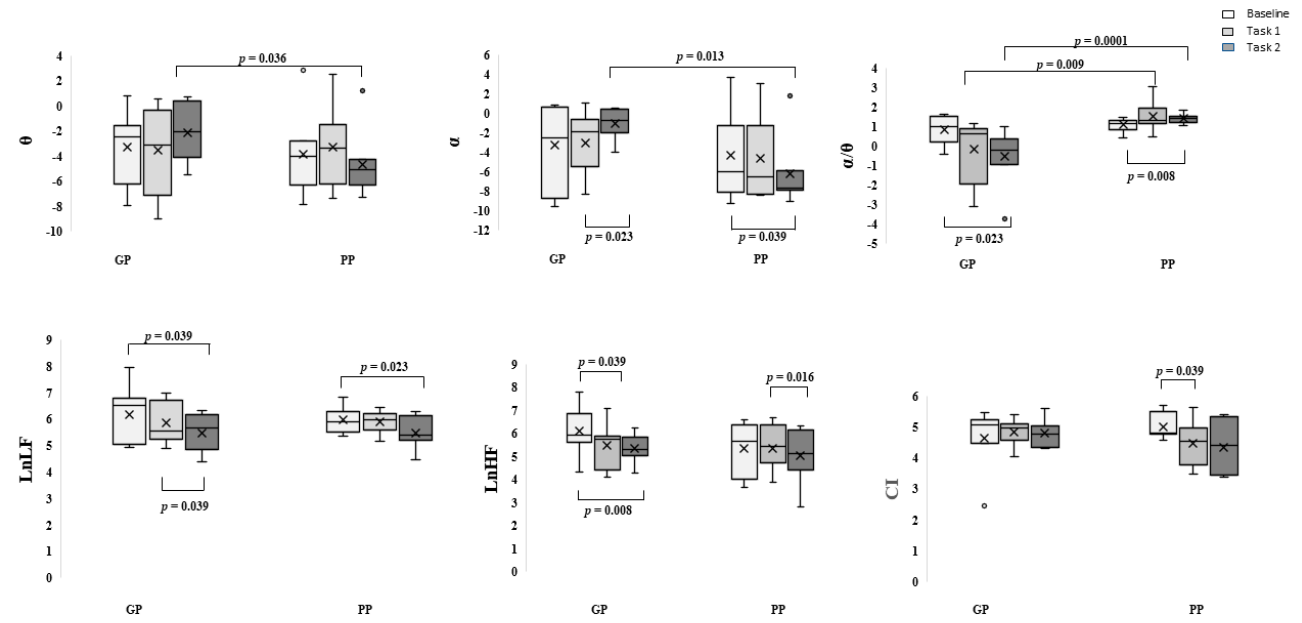
Figure 6. In the first line boxplot α , ϑ , and α / ϑ ratio powerband. In the second line, the natural logarithm of Low Frequency (LF) and High Frequency (HF) and the HRV Complexity Index (CI). In light gray, the baseline, medium gray task 1, and dark gray task 2. GP the group with Good Performance; PP the group with Poor Performance. In the graph, the extremities of the box represent the first (25th percentile) and the third (75th percentile) quartile, and the whiskers represent the minimum (0th percentile) and maximum (100th percentile). The central line is the median (50th percentile), the (x) is the mean, and the (o) upper or below the whiskers are the outliers. The GP group showed in baseline a negative correlation between CI and α / ϑ (Rho = − 0.857, p = 0.007). In task 1, there was a negative correlation between LnLF and LnHF with α / ϑ ratio, (Rho = − 0.964, p = 0.0001; Rho = − 0.929, p = 0.001, respectively), and in task 2, LnLF was negatively correlated with Reaction Time (Rho = − 0.893, p = 0.003) and positively with power α band (Rho = 0.786, p = 0.018). The PP group showed no correlations at base- line. In task 1, the CI was negatively correlated with the errors (Rho = − 0869, p = 0.006) and α / ϑ (Rho = − 0.786, p = 0.018), while α / ϑ was positively correlated with the errors (Rho = 0.725 p = 0.02); in task 2, LnHF was positively correlated with α / ϑ (Rho = 0.964, p = 0.0001) (Figures 7 and 8). Figure 7. Correlation between HRV parameters (Complexity Index (CI), HF power (LnHF), LF power (LnLF)) and EEG α , ϑ , and α / ϑ ratio EEG powerbands of the group with Good Performance (GP) and of the group with Poor Performance (PP). Green and dashed red lines are the positive and negative correlations, respectively.